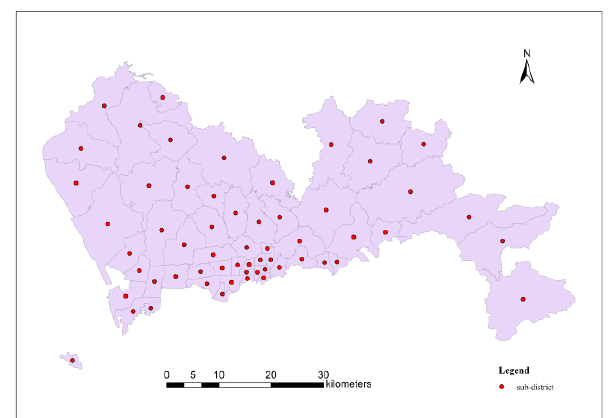
Figure 4. The case data points in each